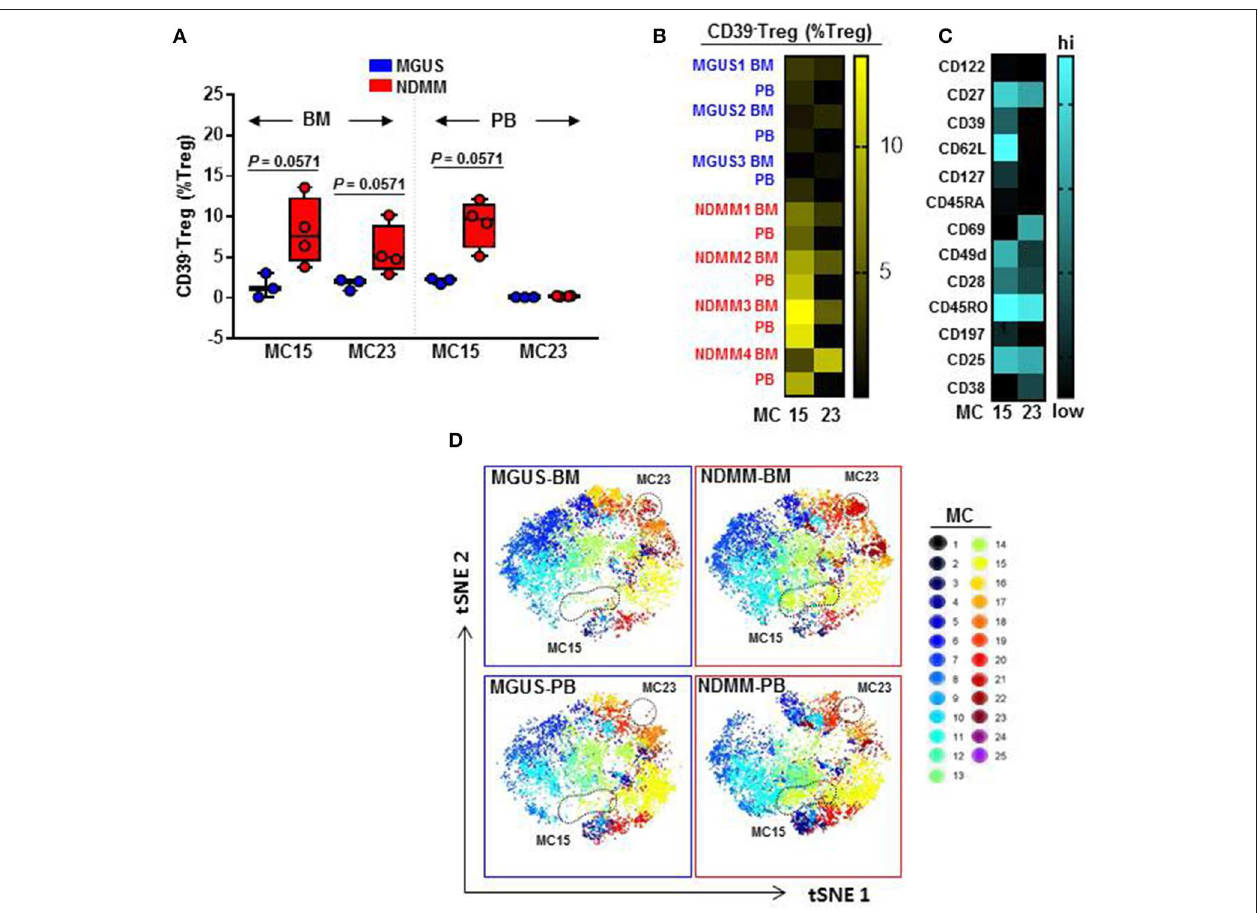
FIGURE 4 | Activated CD39 − Treg and BM-resident CD39 − Treg emerge in NDMM patients. (A) Frequency of Treg in MC15 and MC23 in BM and PB of MGUS ( n = 3) and NDMM ( n = 4) patients. Box and whisker plots show min and max, with median and individual data points. (B) Heatmap of Treg frequency in MC15 and MC23 in individual BM and PB from MGUS ( n = 3) and NDMM patients ( n = 4). (C) Phenotype of Treg in MC15 and MC23. (D) t-SNE plots display MC in pooled BM and PB of MGUS ( n = 3) and NDMM ( n = 4) patients colored according to the accompanying legend. MC15 and MC23 are indicated by dotted